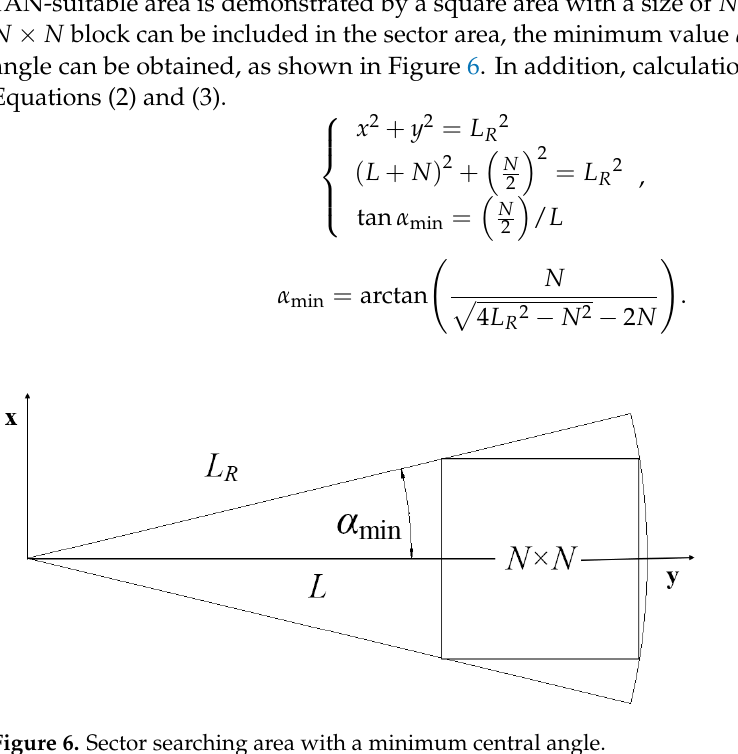
Figure 5. Parameters of sector searching area.